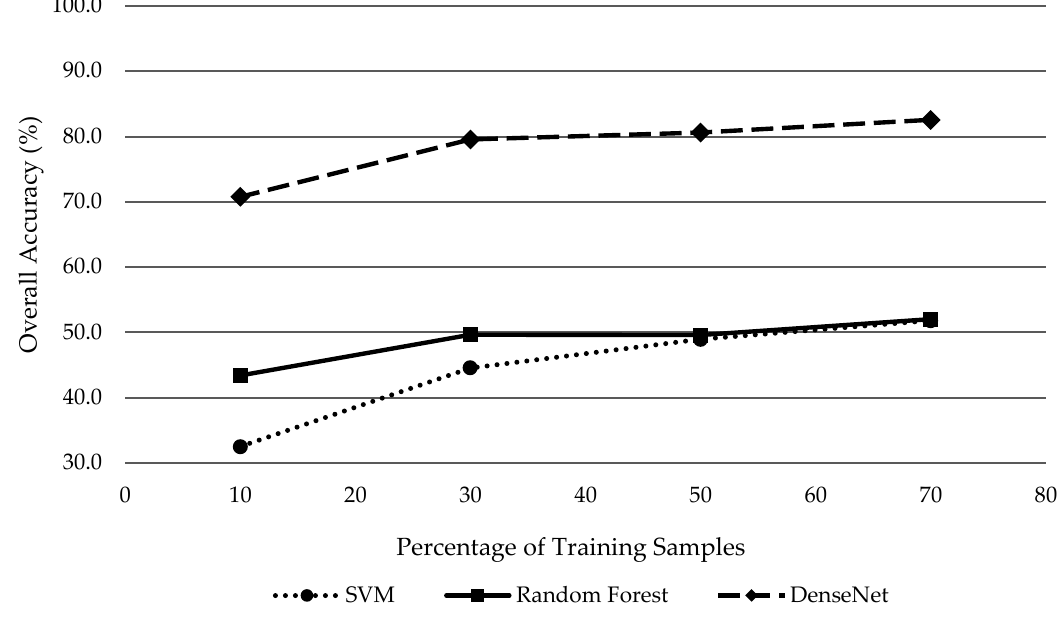
Figure 8. Overall accuracy for SVM, RF, and DenseNet classifiers using 10% training, 30% training, 50% training and 70% training from the total samples for each species using 18 bands.